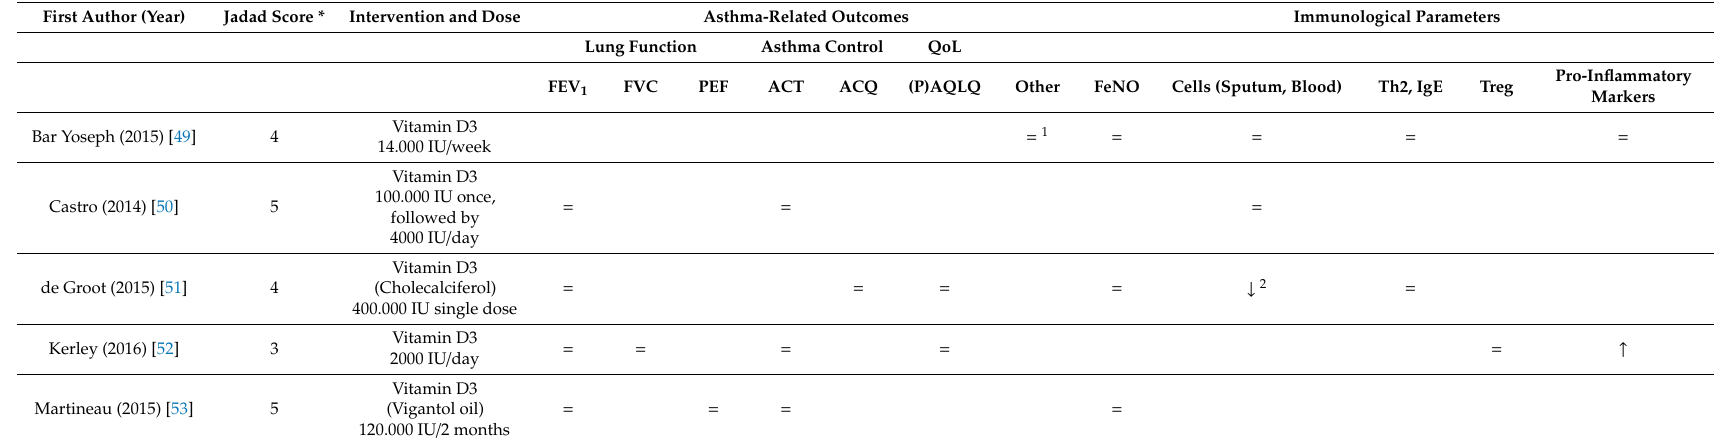
Table 5. Changes in asthma-related outcomes and immunological parameters as compared to the control group for the vitamin D3